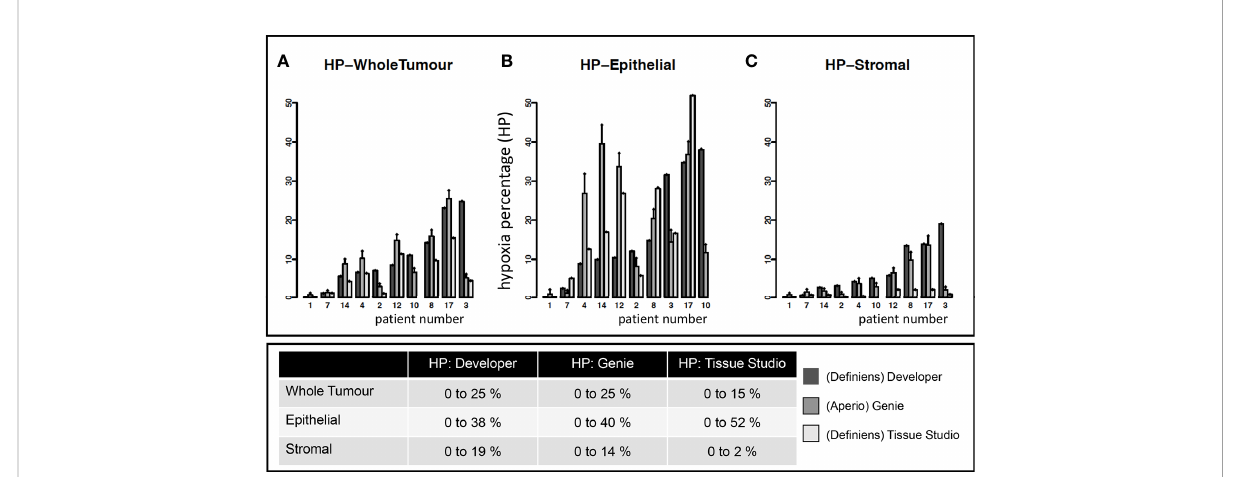
FIGURE 3 Estimates of tumoral hypoxia by different image analysis platforms. Each point on the x-axis represents a unique study patient. Each patient (except 10) has estimates of hypoxia on De fi niens Developer, Genie, and Tissue Studio as indicated by different colored bars. Y-axis shows the hypoxia percentage (HP) (i.e., pimonidazole-detected hypoxia) in speci fi c tumor compartments: (A) whole tumor, (B) epithelial, and (C) stromal tumor compartments.